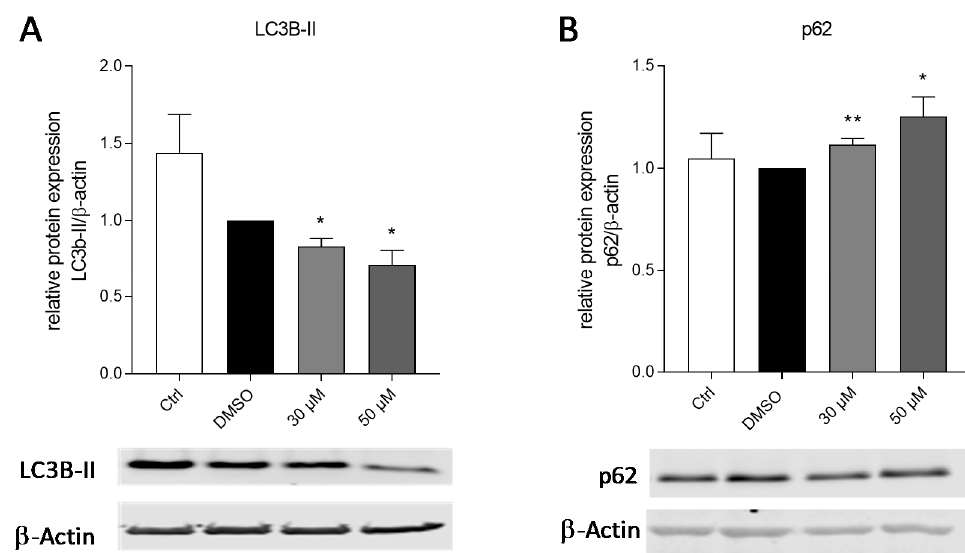
Figure 4. Expression of autophagy markers in SK-Mel-28 cells after amlexanox treatment. ( A ) Light chain 3B (LC3B)-II and ( B ) p62 expression in SK-Mel-28 cells after treatment with amlexanox or vehicle (DMSO). The Western blots show one representative blot out of three independent experiments ( n = 3); the bar diagrams show the densitometric analysis of all the blots. * P < 0.05, ** P < 0.01, in comparison to vehicle-treated control cells.